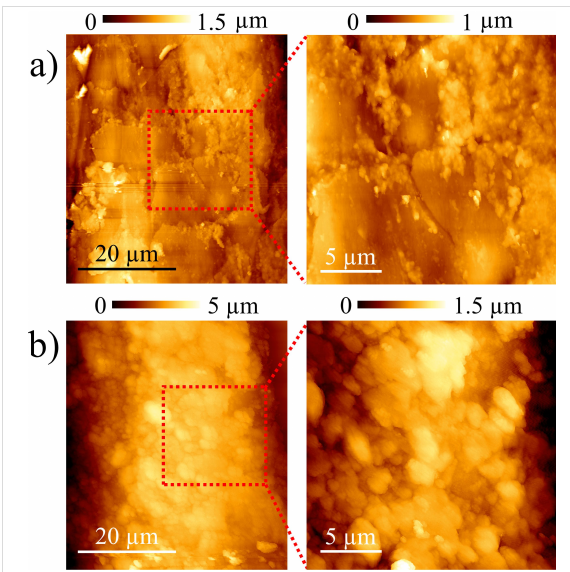
Figure 7: Sample 1 (a) and 2 (b) surfaces covered by rosin particles, in the same conditions employed during the last performance.